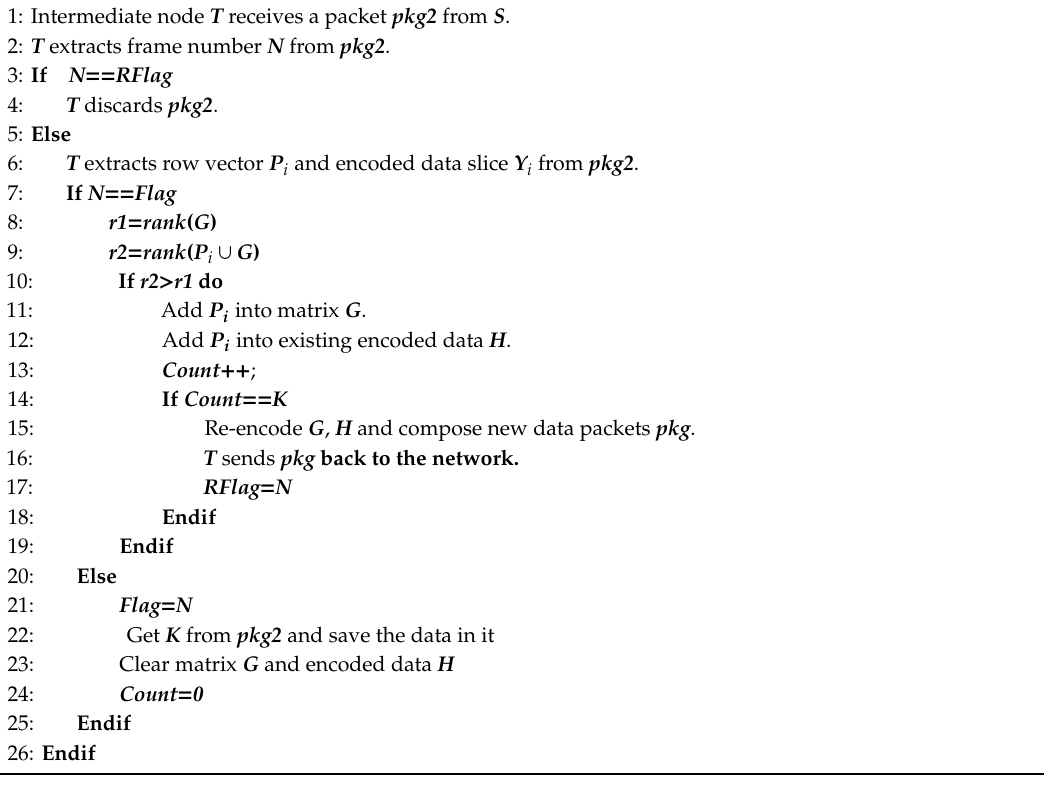
Algorithm 2 Re-encoding strategy